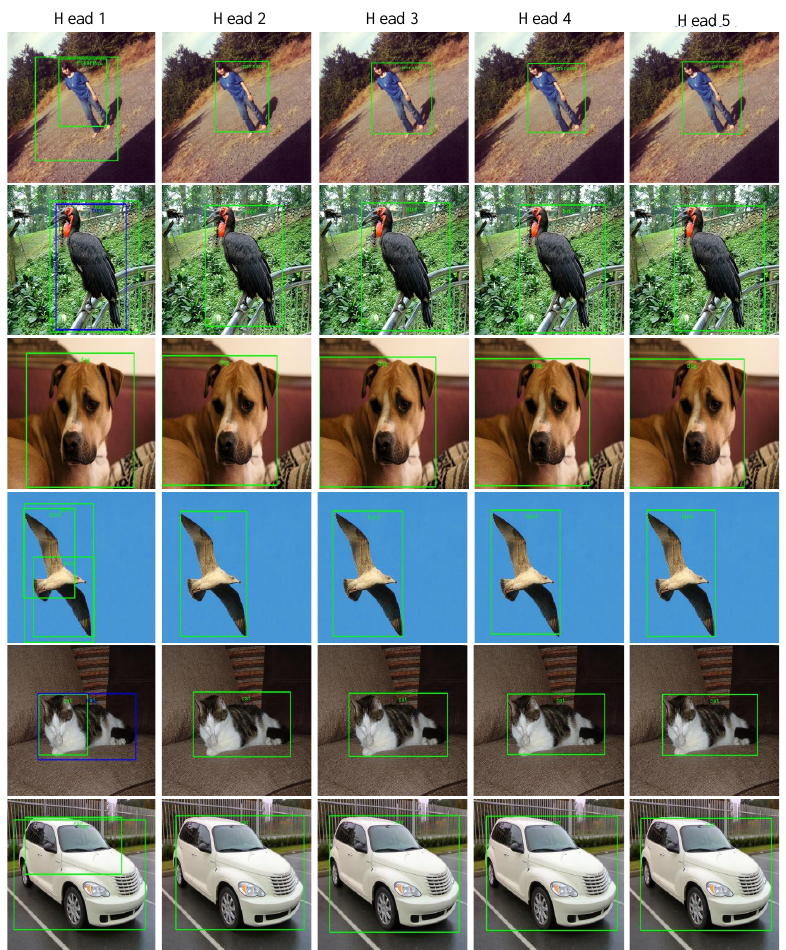
Figure 9. Qualitative comparison between different detection head on Pascal voc dataset. The first column to the fifth column are the detection results of the detection head 1 to the detection head